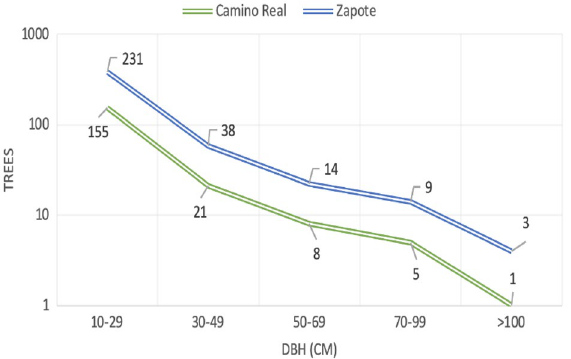
Figure 1. The distribution of trees based on diameter at breast height (DBH) for the Camino Real and Zapote plots.